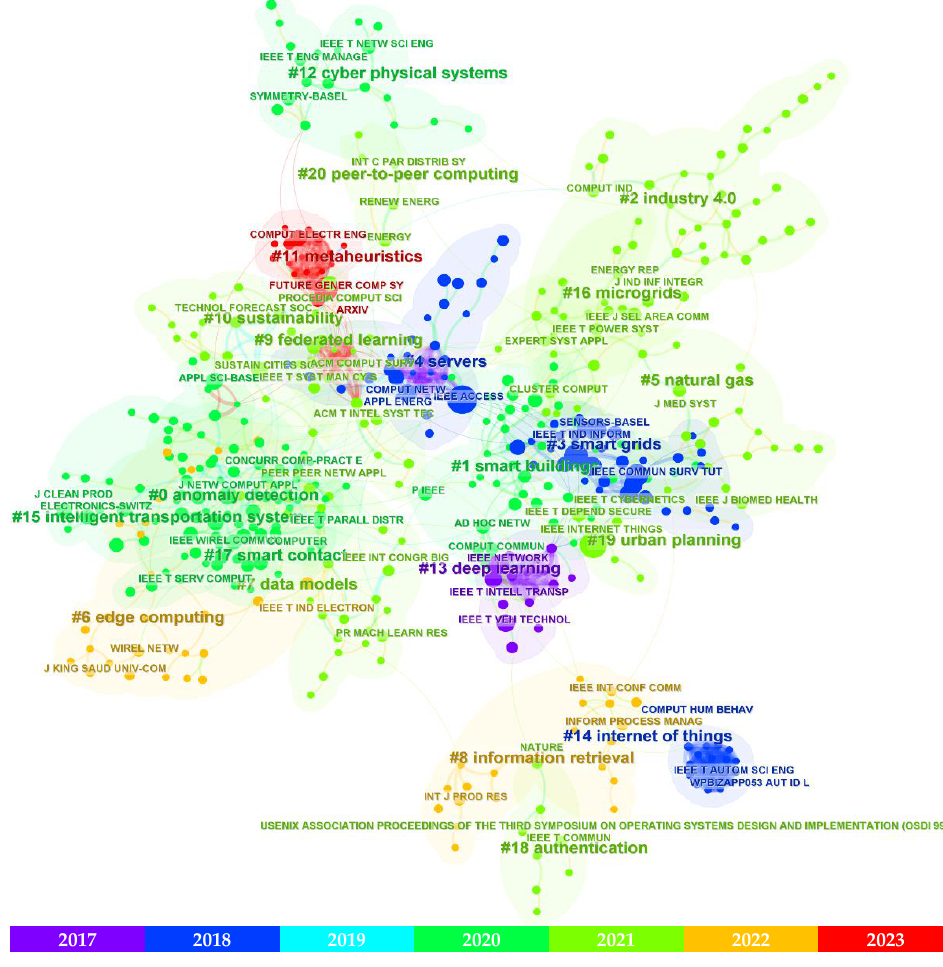
Figure 13. Largest source co-citation clusters in the subject field.